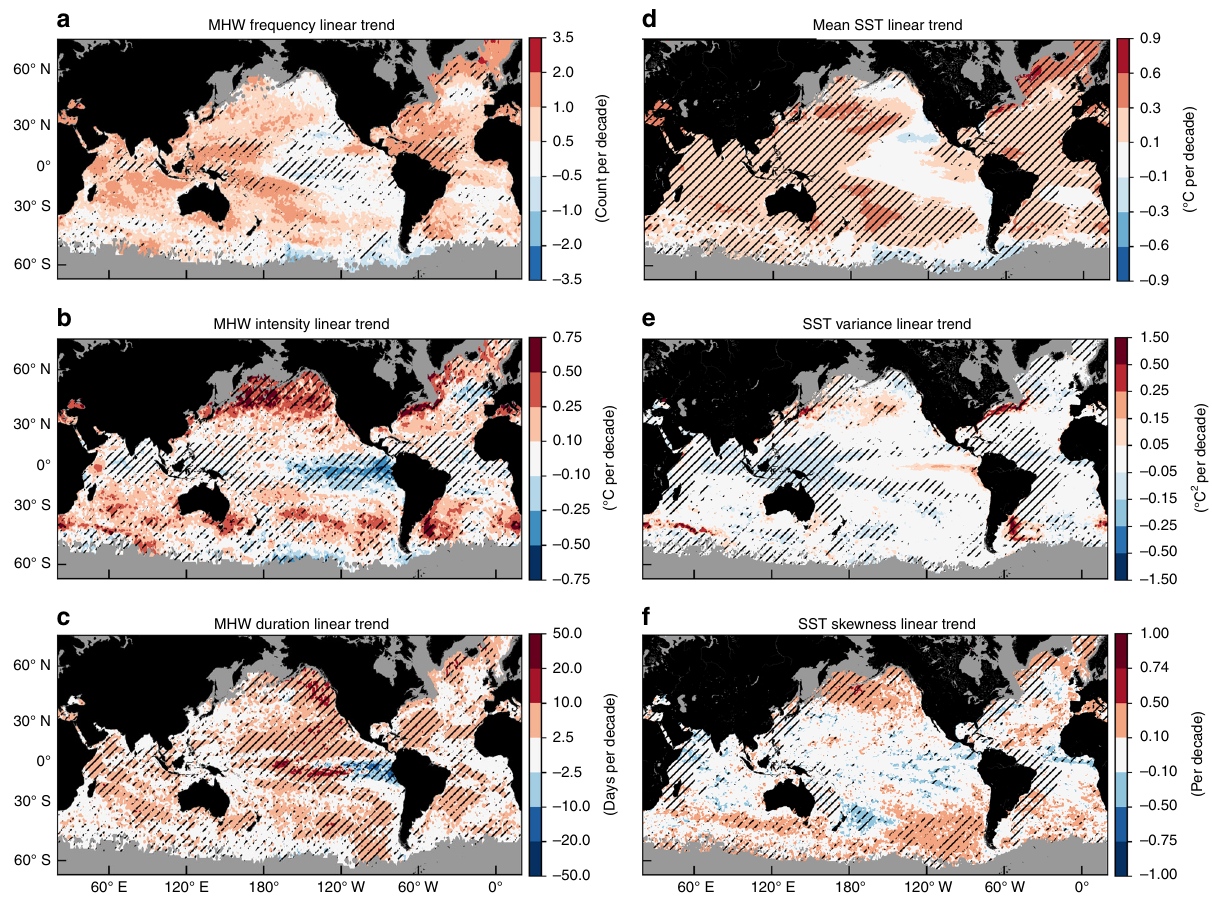
Fig. 3 Identi fi cation of excess trends in marine heatwave properties globally. Shown are linear trends in a marine heatwave frequency, b marine heatwave intensity, c marine heatwave duration, d annual mean SST, e annual SST variance and f annual SST skewness from NOAA OI SST over 1982 – 2016. Hatching in a – c indicates the linear trend is signi fi cantly different from what is expected solely due to the rise in the annual mean SST (at the 5% level), based on the statistical climate model. Hatching in d – f indicates the linear trend is signi fi cant from zero ( p < 0.05)